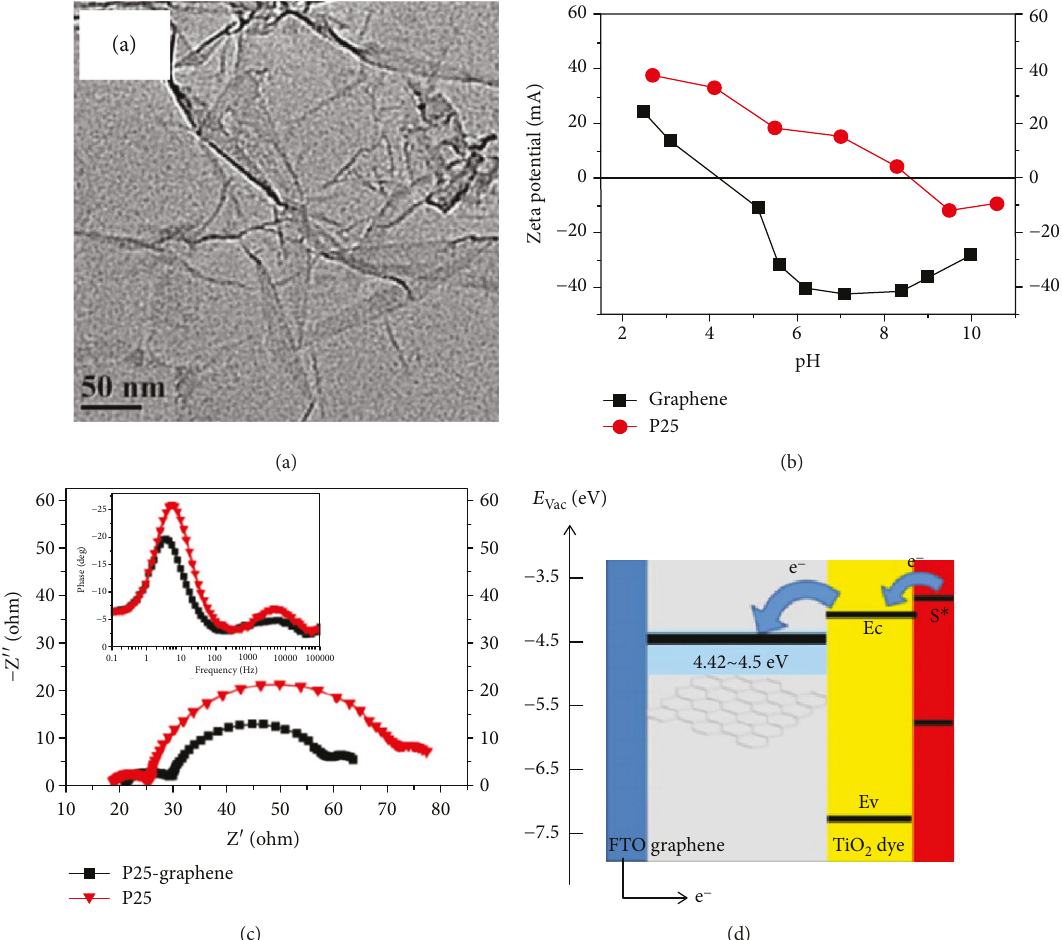
Figure 9: (a) TEM image of the graphene dispersed by Na fi on. (b) Zeta potential as a function of pH for Na fi on-functionalized graphene and P25. (c) EIS of DSSCs with P25 and P25-graphene electrodes. The inset displays the Bode phase of two fi lms. (d) Schematic diagram for energy band matching